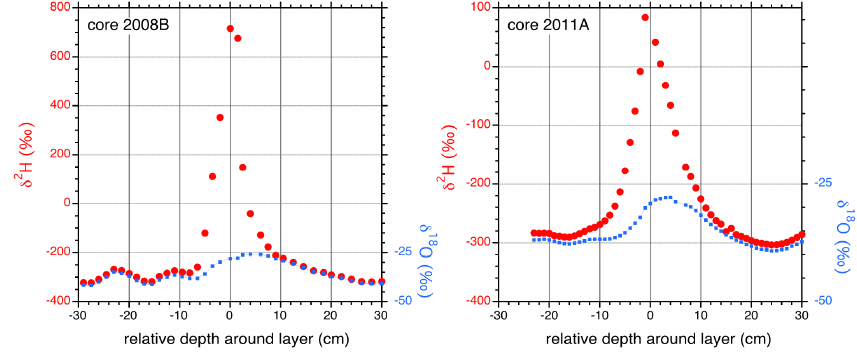
Figure 5. Two examples of δ 2 H profiles obtained in this work, from 2008 (core B) and from 2011 (core A). The effect of diffusion is directly visible, both in the width of the peak and in its height. The δ 18 O signal is shown in blue, with scale ratio 1:8 with respect to the δ 2 H scale.